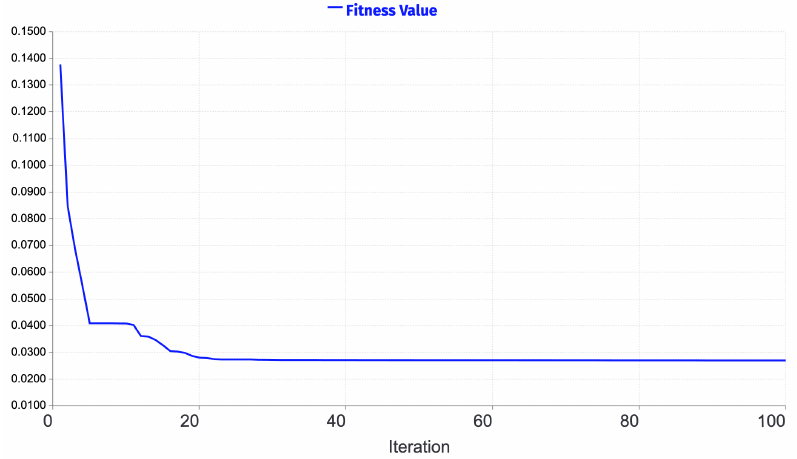
Figure A13. The training convergence curve when using the ANN with the PSO and the MSE fitness function for the dataset of Polish companies.